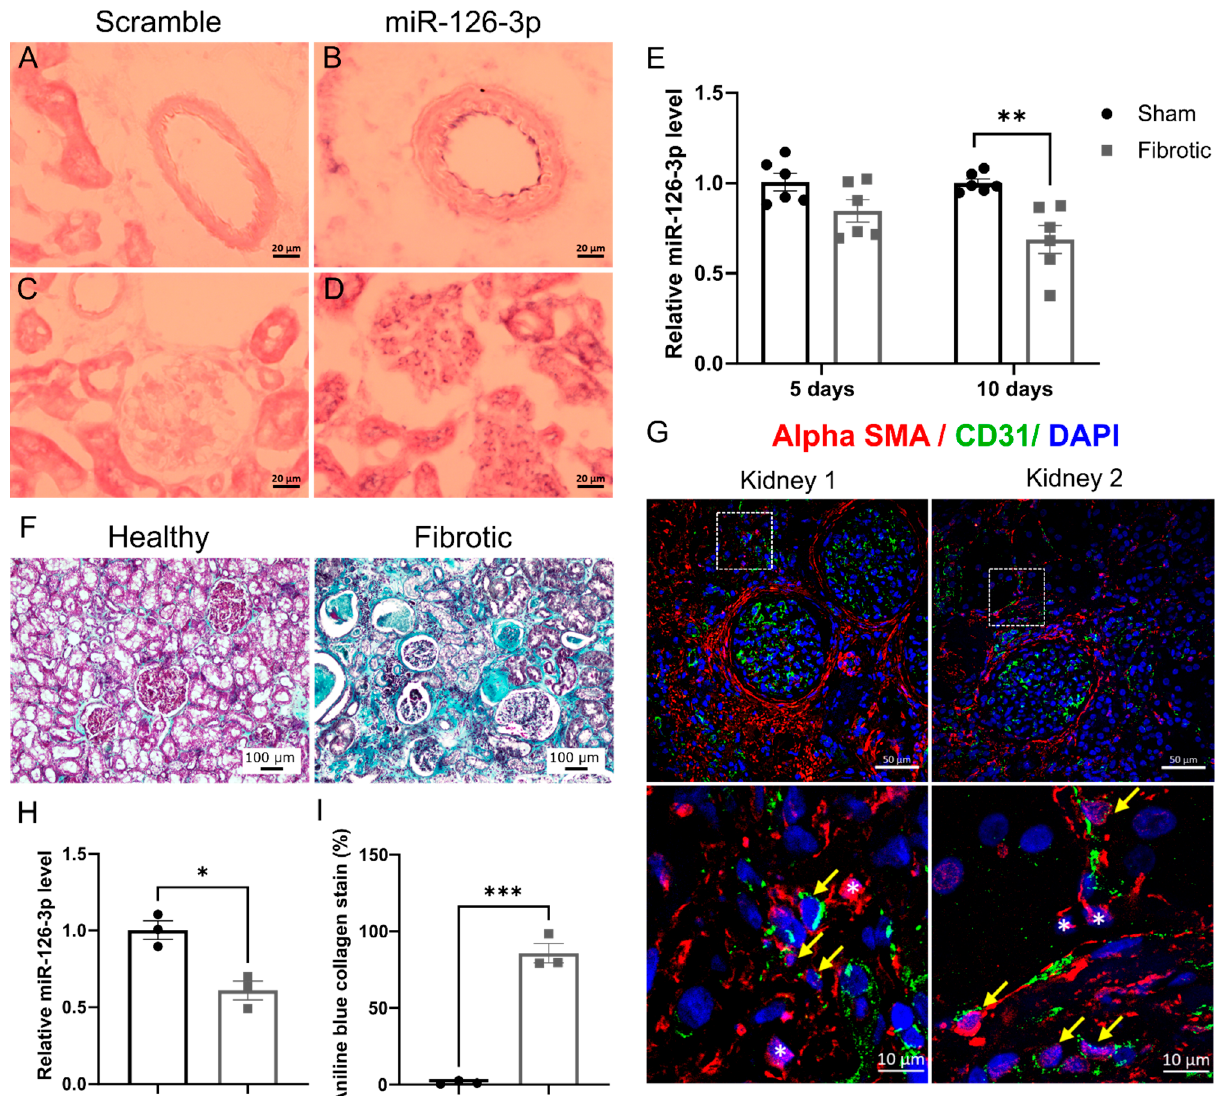
Figure 6. MiR-126-3p is expressed in renal endothelial cells and is down-regulated in fibrotic kidneys. ( A – D ) In situ- hybridisation was performed on frozen sections of healthy mouse kidneys with 40 nM of miR-126-3p or scramble double- DIG labelled LNA probes. The micrographs show blood vessel ( A , B ) or glomeruli ( n = 2) ( C , D ). ( E ) RT-qPCR analysis of miR-126-3p in sham operated, 5 and 10 days post-UUO kidneys. Expression was normalised to the expression of the housekeeping gene SnoRNA 202 ( n = 6). ( F ) Masson trichrome staining in human normal and fibrotic kidneys (light blue staining indicates connective tissue staining). ( G ) Sections of human fibrotic kidneys were stained for α SMA and CD31. A higher magnification (white square) is shown in the lower panel for each kidney. Co-stained CD31 + α SMA+ cells were indicated with a yellow arrow. Single α SMA+ cells were designated by white stars. ( H ) Expression of miR126-3p was assessed by RT-qPCR in normal and fibrotic human kidneys. Expression was normalised to the expression of the house- keeping gene RNU48 and errors bars are standard error of the mean ( n = 3). ( I ) Quantification of aniline blue collagen stain in Masson trichrome human kidneys sections ( n = 3). Statistical significance was calculated by unpaired t -Test. (* p < 0.05; ** p < 0.01; *** p < 0.001).